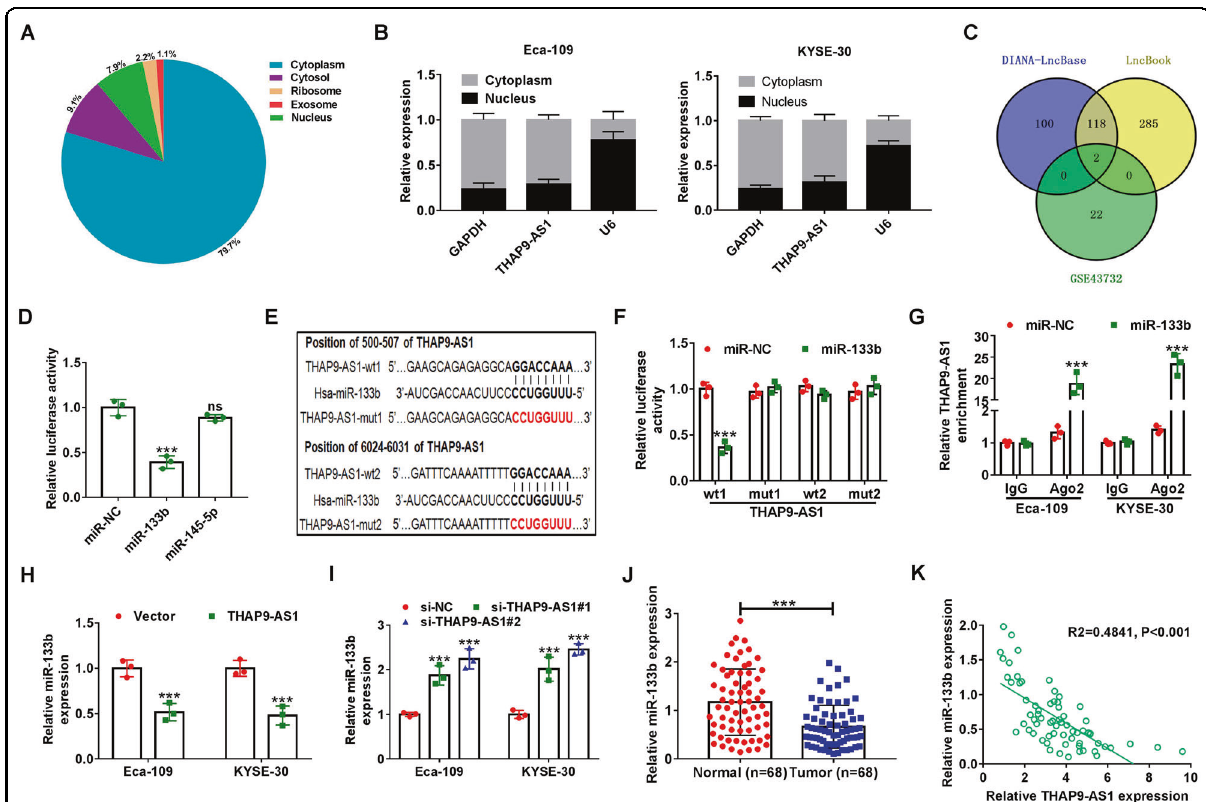
Fig. 3 THAP9-AS1 serves as a sponge for miR-133b in ESCC cells. A The cellular location of THAP9-AS1 was predicted by the online tool lncLocator. B The relative expression of THAP9-AS1 in the cytoplasm and nucleus of ESCC cells was determined via subcellular fractionation and qRT- PCR assays. C By retrieving the GEO dataset (GSE43732) and using algorithms (DIANA-LncBase and LncBook), two downregulated miRNAs (miR-133b and miR-145-5p) in ESCC were identi fi ed to be able to potentially interact with THAP9-AS1. D Dual-luciferase reporter assay was used to evaluate the effect of miR-133b or miR-145-5p on the luciferase activity of THAP9-AS1-wt reporter in Eca-109 cells. E The binding sequences of THAP9-AS1 on miR- 133b and corresponding mutant sequences. F Dual-luciferase reporter experiments were performed in Eca-109 and KYSE-30 cells co-transfected with miR-NC or miR-133b and THAP9-AS1-wt1 or THAP9-AS1-mut1/THAP9-AS1-wt2 or THAP9-AS1-mut2. G miR-NC-transfected or miR-133b-transfected ESCC cells were subjected to anti-Ago2 RIP assay, then qRT-PCR was used to measure the abundance of THAP9-AS1 enrichment in immunoprecipitates. H , I qRT-PCR assays were carried out to measure the expression of miR-133b in Eca-109 and KYSE-30 cells upon THAP9-AS1 overexpression or knockdown. J miR-133b expression in tumor tissues and adjacent normal tissues from 68 ESCC patients was measured by qRT-PCR analysis. K Expression correlation analysis between miR-133b and THAP9-AS1 in ESCC tumor tissues. *** P <